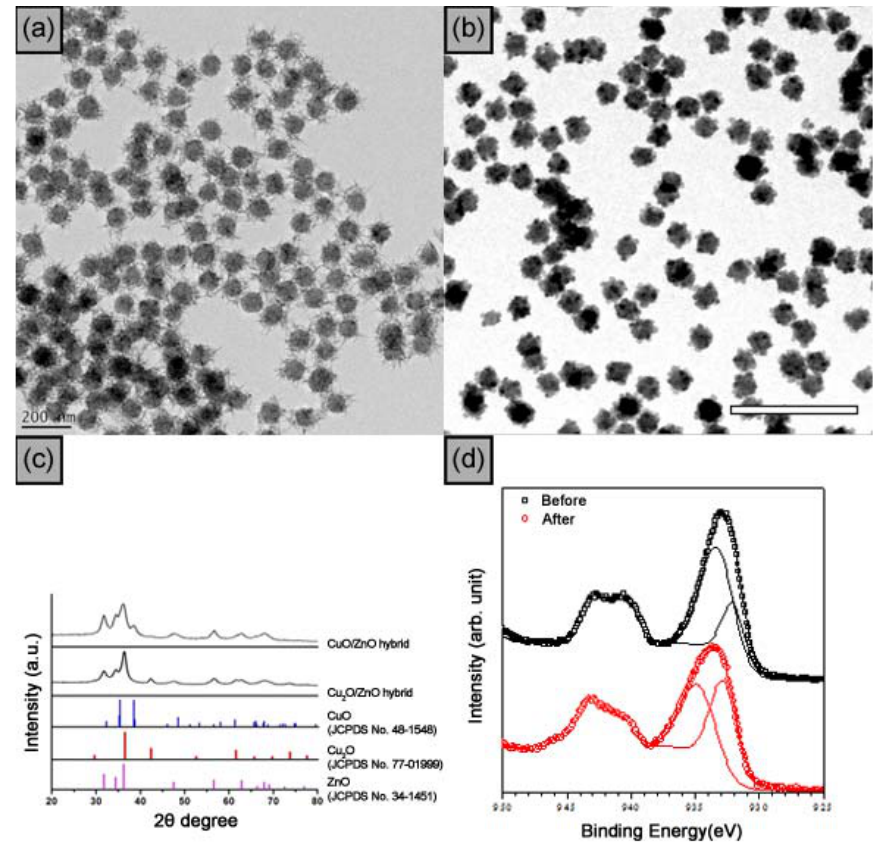
Figure 3. ( a ) ZnO/CuO core-branch nanoparticles; ( b ) TEM images of ZnO/Cu O 2 O and ZnO/CuO hybrid core-shell hybrid nanoparticles; ( c ) XRD spectra of ZnO/Cu 2 nanoparticles; ( d ) XSP spectra of ZnO/CuO hybrid nanoparticles. (Color online) The core-level XPS spectra of Cu 2p before and after chemical reaction. The solid curves 3/2 represent the best-fitted results. The scale bars represent 200 nm ( a , b